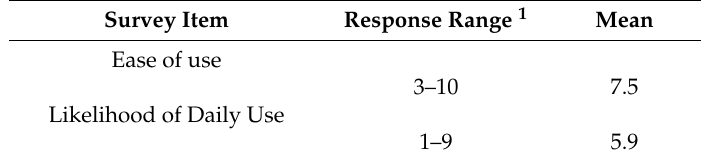
Table 4. Survey results for ease and likelihood of use for the Bridge2U mfood log, n =